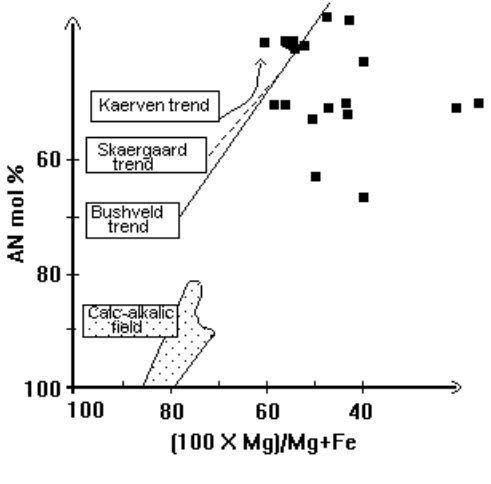
Fig. 16–CoexistingCPXandplagioclasecompositionsfromthe VarzeaAlegre pluton, contrasted with trends from other tholeiitic sequences (Kaerven, East Greenland ; Bushveld and Skaergaard; modified after Burns 1985).